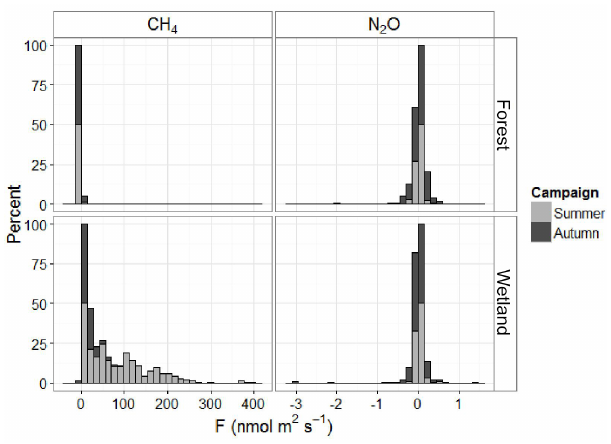
Figure 1. Frequency plot showing distribution of all fluxes across both campaign